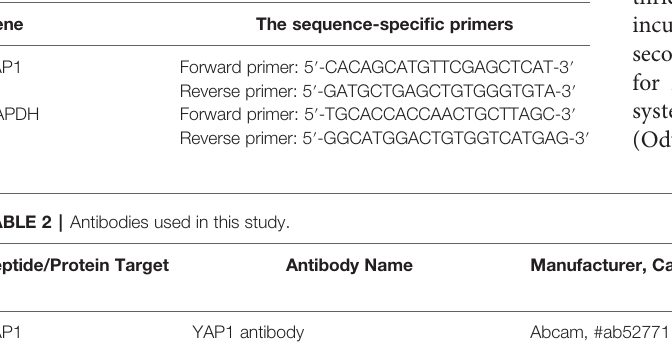
TABLE 1 | Primer sequences used in quantitative real-time PCR.